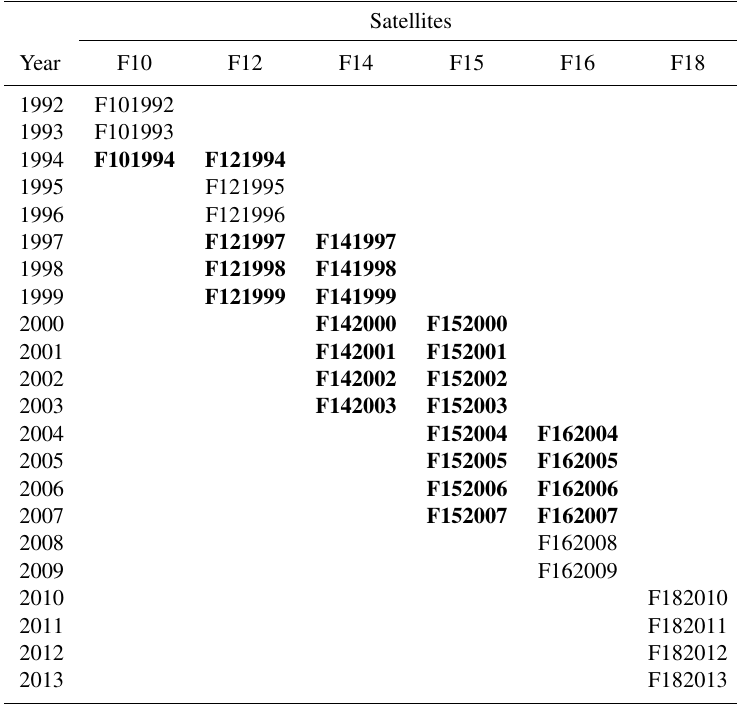
Table 1. DMSP/OLS satellites and overlays in corresponding years.